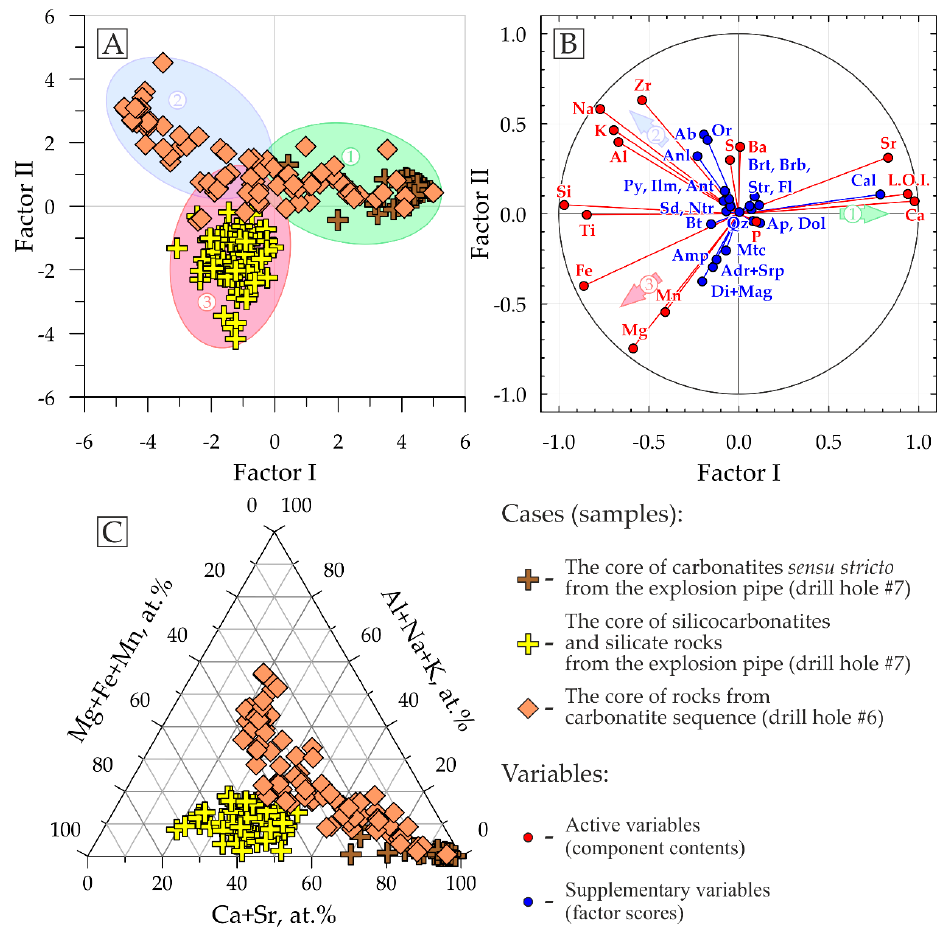
Figure 7. ( A ) Projection of the cases onto the factor-plane (Factor I vs. Factor II), the fields outline the sample groups (details are given in the text); ( B ) projection of the variables onto the factor-plane (Factor I vs. Factor II); ( C ) figurative points of rock compositions on the barycentric diagram in coordinates [Ca + Sr]–[Mg + Fe + Mn]–[Al + Na + K] (atomic%), selected based on the results of classical FA.